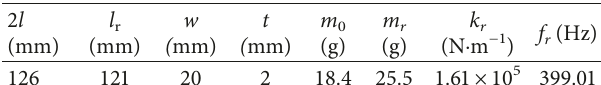
Figure 15: (a) Locally resonant beam with 12 beam-like resonators and (b) experimental environment. Table 4: Size and equivalent parameters of the beam-like resonator in experiment.